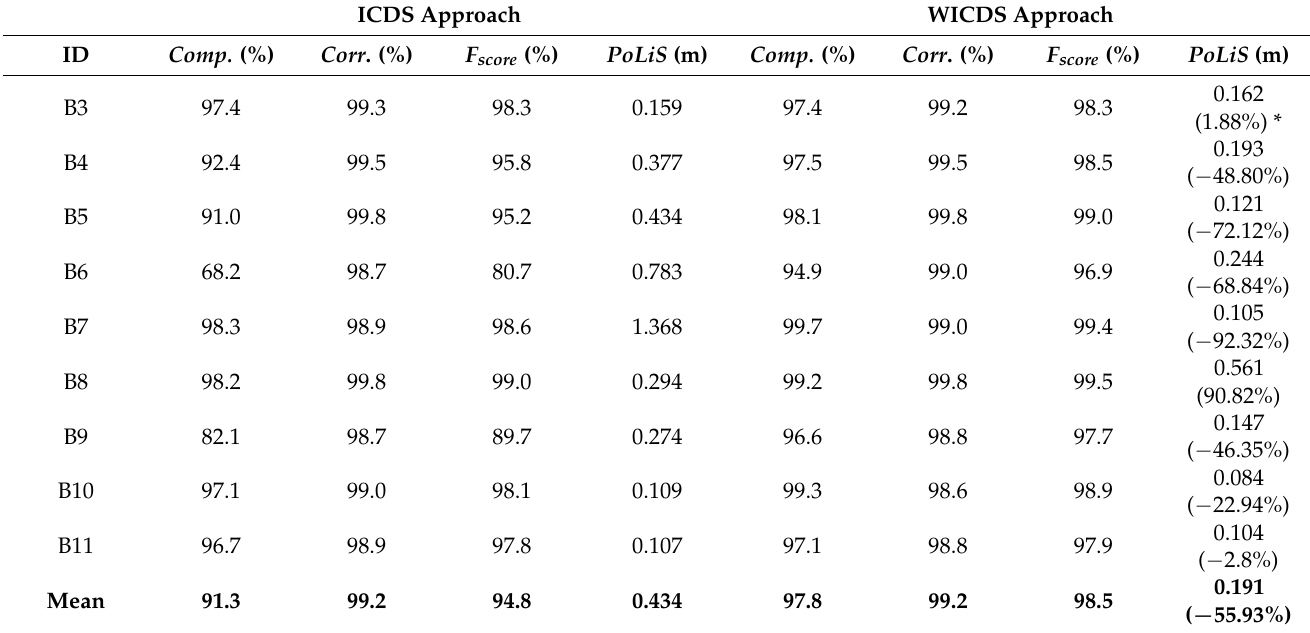
Table 2. Quality metrics for different buildings using the ICDS and WICDS approaches.